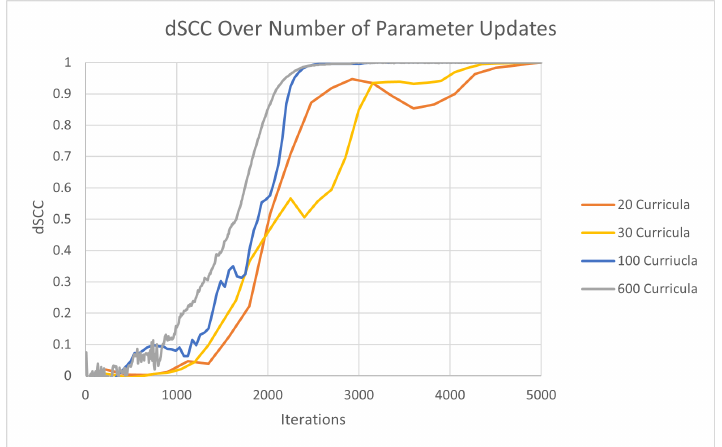
Figure 2. Evolution of distance Spearman Correlation Coefficient (dSCC) over number of iterations for 20, 30, 100, and 600